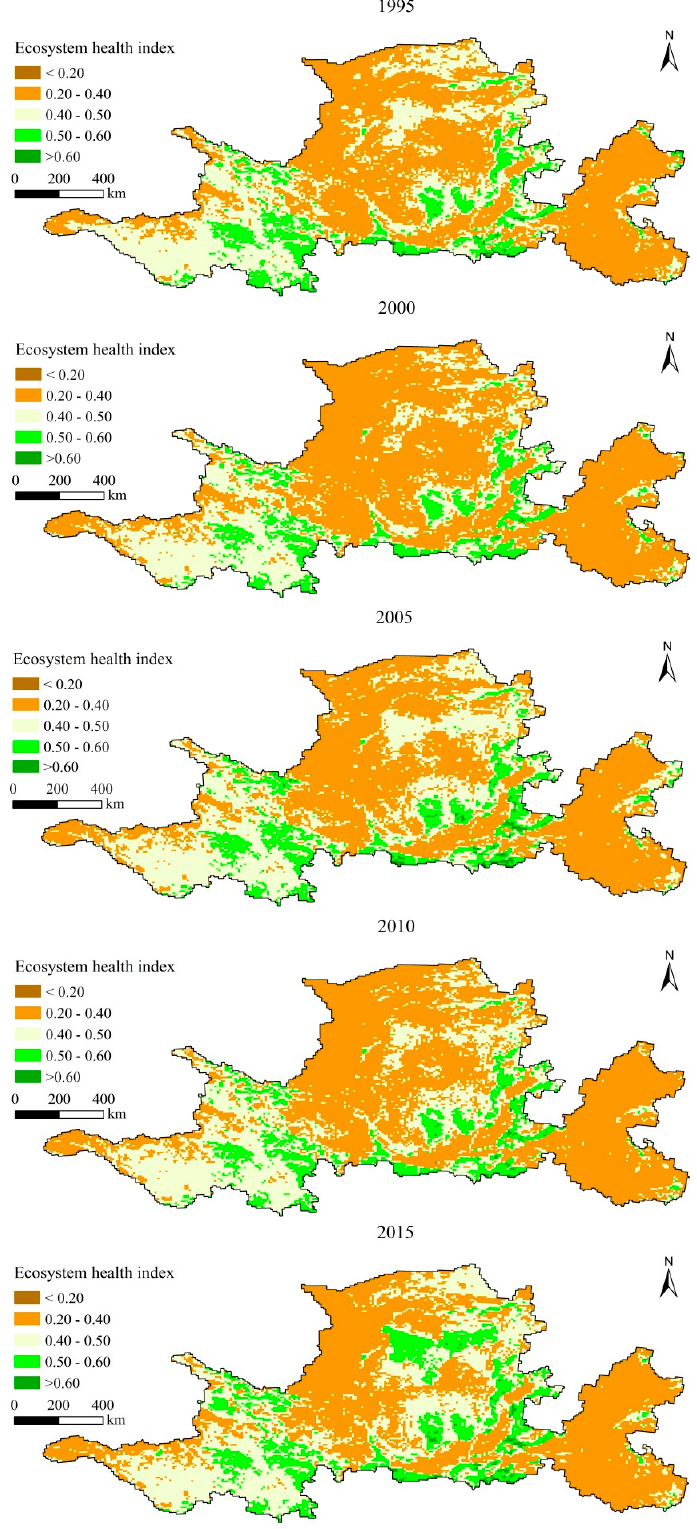
Figure 2. Spatial change of ecosystem health level in study area from 1995–2015.